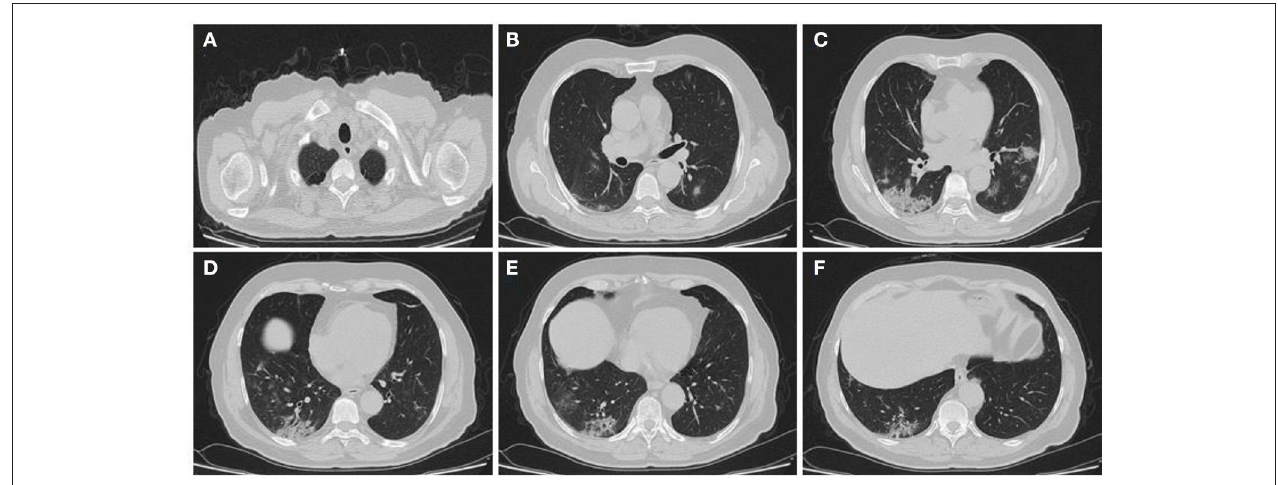
FIGURE 1 | High resolution, axial non-enhanced spiral chest CT images (lung window) of a 69-years old patient who was confirmed to be infected by COVID-19 and admitted to hospital with fever and dry cough. CT images show (A) emphysematous changes in the apices of both lungs and multiple patchy consolidations predominantly in the lower lobe of the right lung (B–F) .